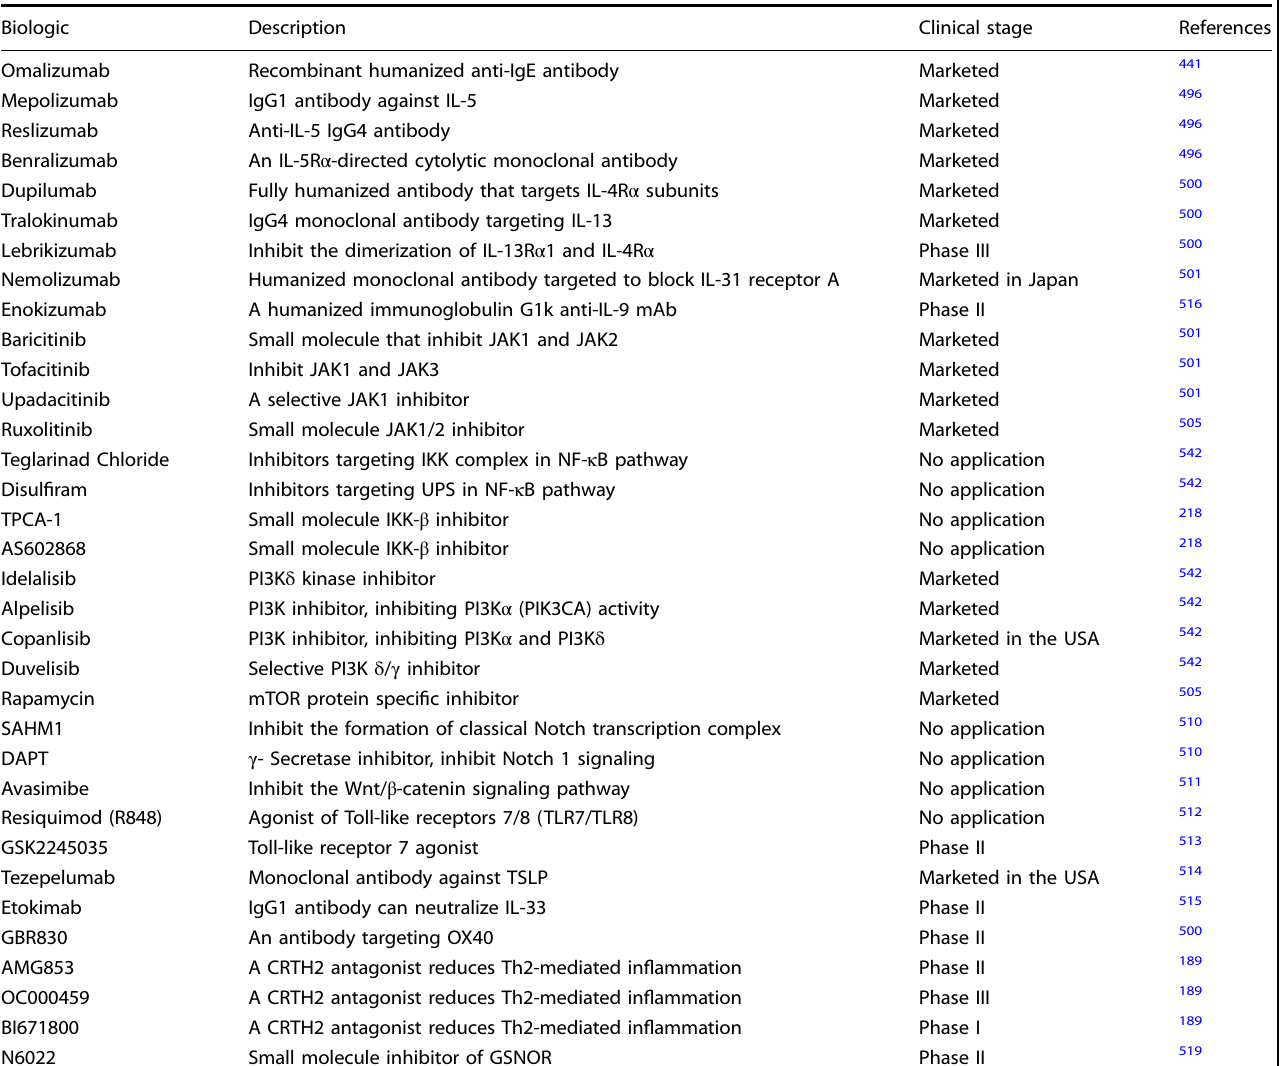
Table 3. Targets and clinical stages of